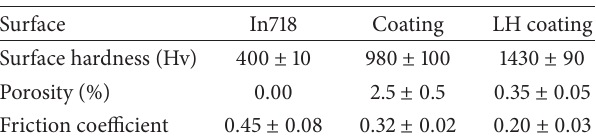
Table 3: Improvement of surface properties by coating and LH coating.